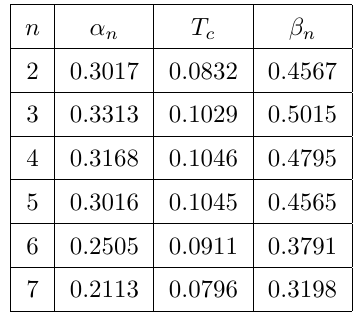
Table 5. (cid:11) n values for the best (cid:12)t curves (3.4), Upper bounds for T c and (cid:12) n values for the inequality